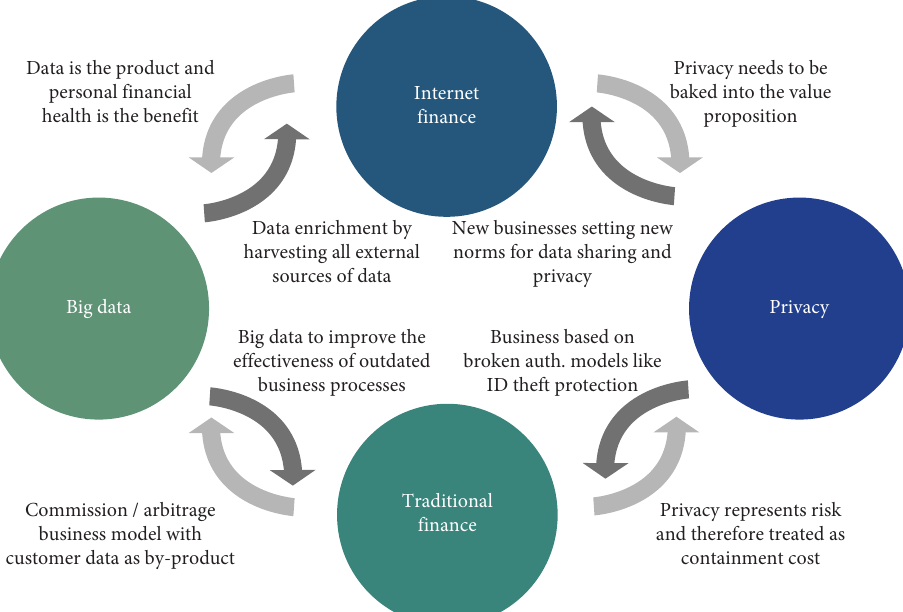
Figure 1: Common modeling methods and processes in financial